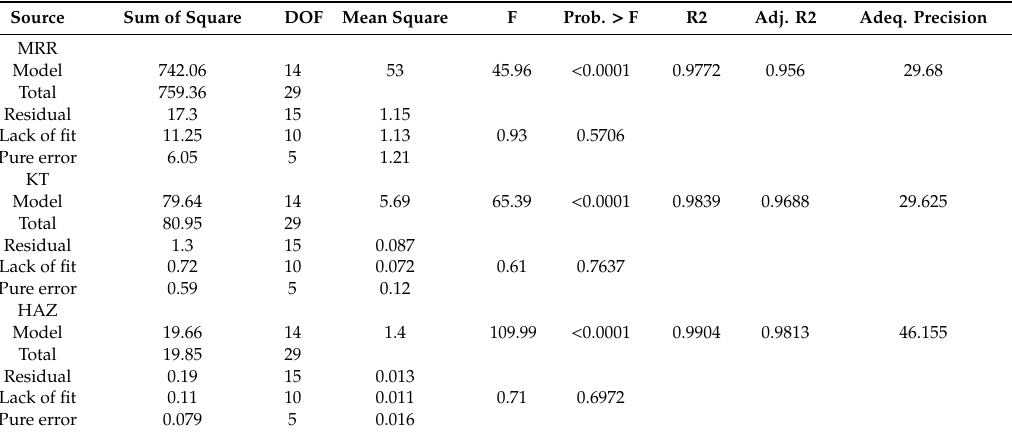
Table 3. Analysis of variance and model